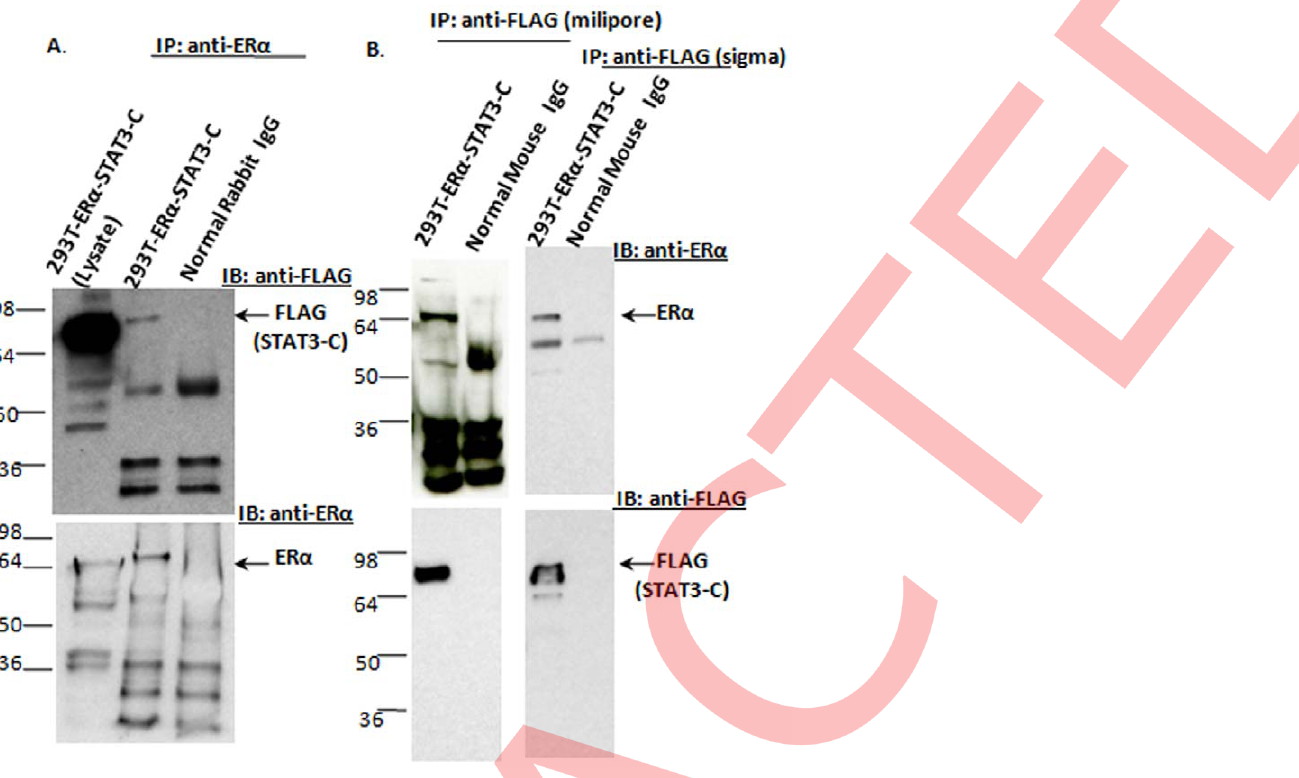
Figure 6. STAT3 physically interacts with ER a . To confirm whether there is a physical interaction between STAT3 and ER a , we transfected 293T cells with FLAG-tagged STAT3-C (2 m g) alone or together with ER a (2 m g). 48 h after transfection, cells were treated with 1 nM E2 for 3 h. Cell lysates were immunoprecipited with anti-ER a and immunoblotted with anti-FLAG as shown in Figure 6A. Figure 6B showed that cell lysates were first immunoprecipitated with anti-FLAG from two different commercially available resources (Millipore and Sigma) respectively followed by immunoblotted with anti-ER a . The results from Figure 6 indicate that STAT3 indeed directly interacts with ER a .